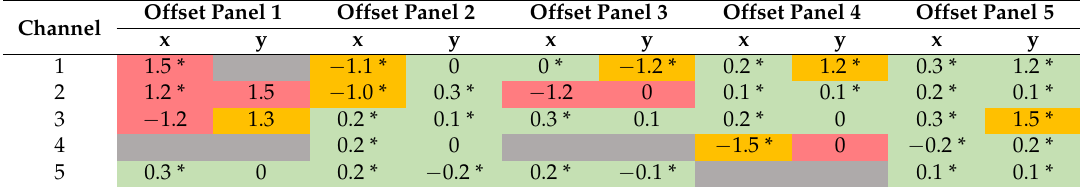
Table 3. Results of the second electrical test after encapsulation by FAM processing of the five test panels. Green stands for a calibrated signal and orange for a signal within tolerance range. Gray marks the channels that were dysfunctional from the beginning, and red shows malfunctioning stacks after encapsulation. The * identifies a change of the signal to the test